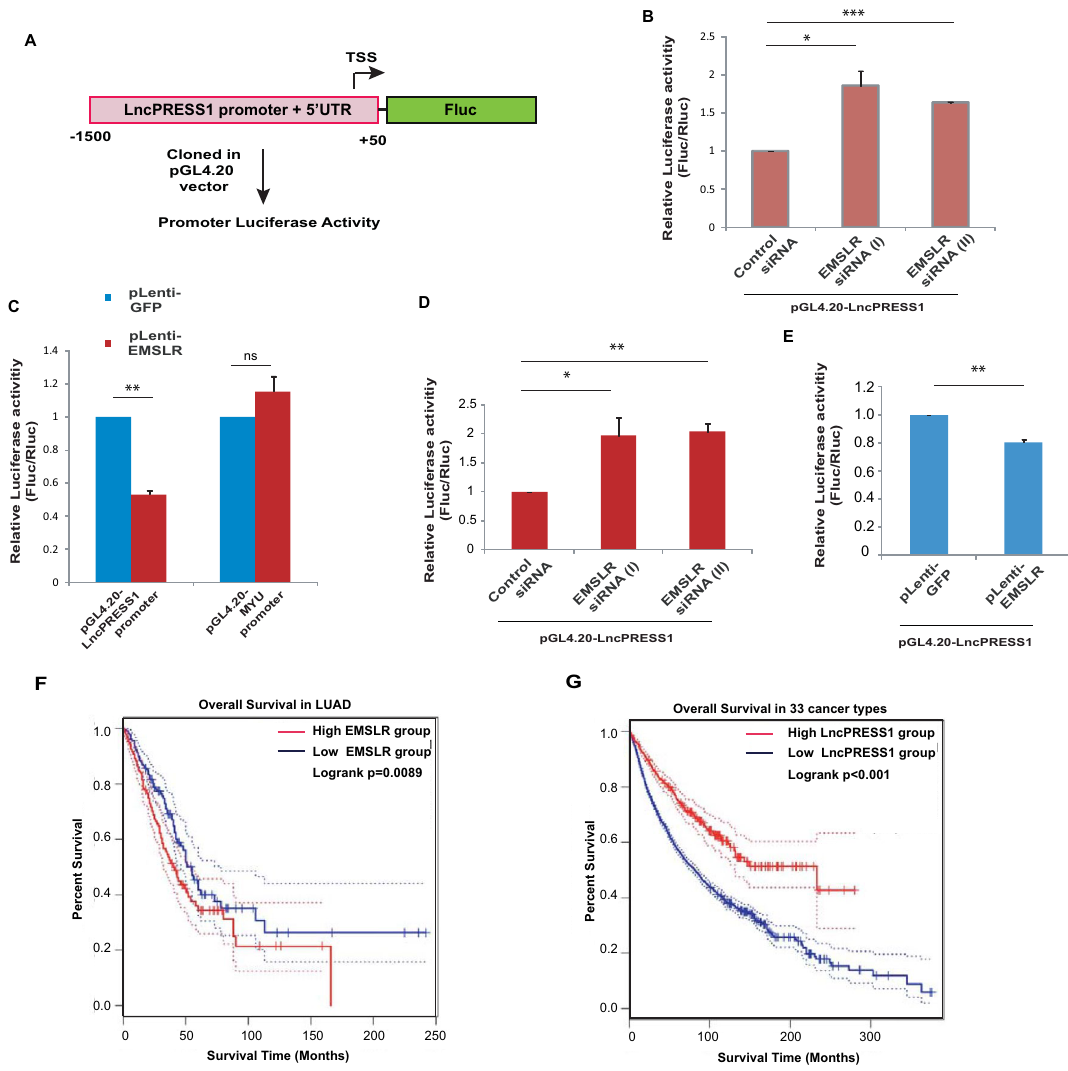
Figure 5. EMSLR mediates the transcriptional repression of LncPRESS1 . ( A ) Schematic representation of the reporter plasmid containing the human LncPRESS1 upstream region: The LncPRESS1 promoter and 5 ′ UTR region spanning − 1500 bp to + 50 bp with respect to transcriptional start site (TSS) was used to drive expression of the firefly luciferase gene (Fluc) in promoterless pGL4.20 vector (promega). ( B ) Depletion of EMSLR , by transfecting EMSLR siRNA (I) or siRNA (II), relieves the repression of LncPRESS1 promoter in A549 cells. The pGL4.20 vector containing LncPRESS1 promoter was transfected into control or EMSLR -depleted A549 cells together with a renilla luciferase (pRL-TK) reporter vector and both luciferase activities were measured after 24 h. The relative luciferase activity in each sample is expressed as a ratio of firefly to renilla luminescence. ( C ) A549 cells were infected with lentivirus expressing EMSLR followed selection with puromycin to obtain stable cells. The pGL4.20 vector containing LncPRESS1 promoter was transfected into control or EMSLR -expressing stable A549 cells together with a renilla luciferase (pRL-TK) reporter vector and both luciferase activities were measured after 24 h. The relative luciferase activity in each sample is expressed as a ratio of firefly to renilla luminescence. ( D ) Depletion of EMSLR , by transfecting EMSLR siRNA (I) or siRNA (II), relieves the repression of LncPRESS1 promoter in H1299 cells. The pGL4.20 vector containing LncPRESS1 promoter was transfected into control or EMSLR -depleted H1299 cells together with a renilla luciferase (pRL-TK) reporter vector and both luciferase activities were measured after 24 h. The relative luciferase activity in each sample is expressed as a ratio of firefly to renilla luminescence. ( E ) H1299 cells were infected with lentivirus expressing GFP or EMSLR followed by selection with puromycin to obtain stable cells. The pGL4.20 vector containing LncPRESS1 promoter was transfected into GFP or EMSLR -expressing stable H1299 cells together with a renilla luciferase (pRL-TK) reporter vector and both luciferase activities were measured after 24 h. The relative luciferase activity in each sample is expressed as a ratio of firefly to renilla luminescence. ( F ) Kaplan–Meier estimates of the survival of patients with low or high levels of expression of EMSLR in LUAD. The expression and survival information was downloaded from GEPIA (Gene Expression Profiling Interactive Analysis) platform. ( G ) Kaplan–Meier estimates of the survival of patients with low or high levels of expression of LncPRESS1 . The sample size of LUAD was insufficient for correlating survival probability with LncPRESS1 expression. Thus the survival probability was calculated in a combination of samples from all 33 cancers available at GEPIA with a high group cutoff of 10% and low group cutoff of 90%. The data is represented as mean of two independent experiments ± S.D. p values were calculated using two-tailed t-test (* p < 0.05; ** p < 0.01, *** p < 0.001, ns,